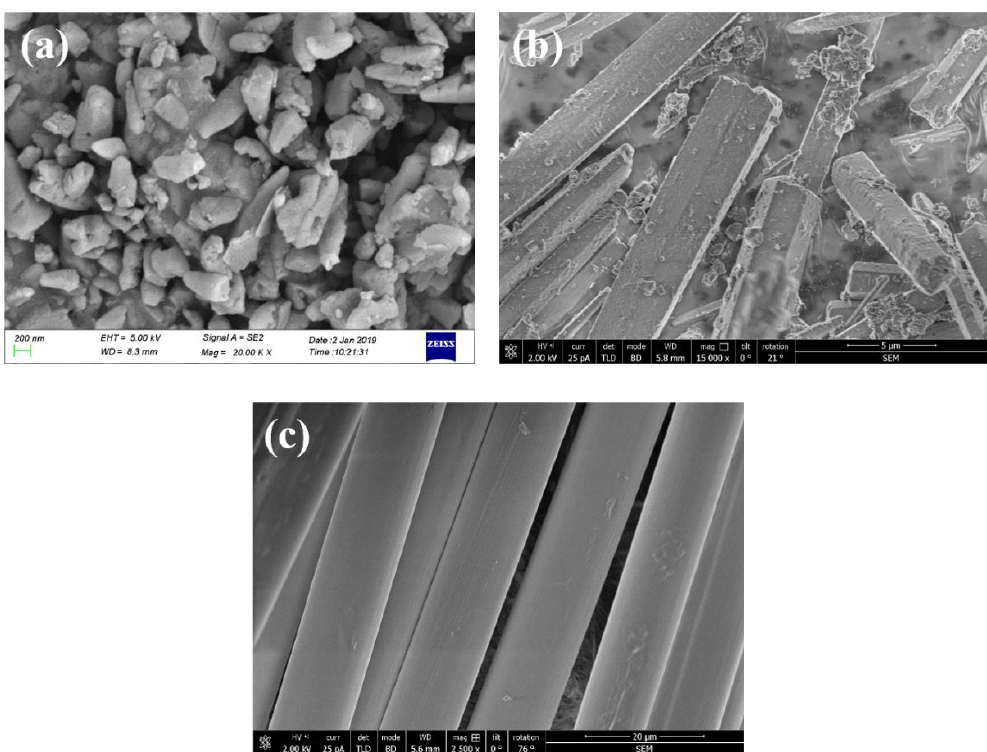
Figure 6. Scanning electron microscopy (SEM) results of nano-CaCO 3 , CaCO 3 whiskers, and aramid fibers ( a ) nano-CaCO 3 , magnification: 20,000×, ( b ) CaCO 3 whiskers, magnification: 15,000×, ( c ) aramid fibers, magnification: 2500×.